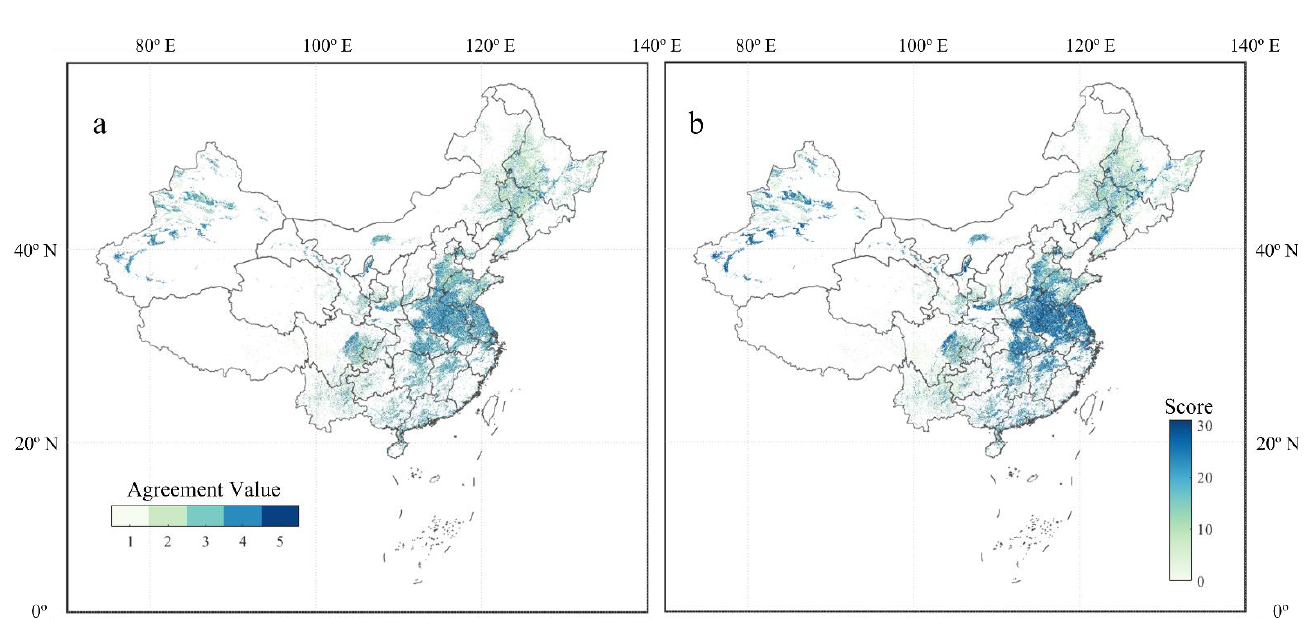
Figure 3. The spatial agreement levels ( a ) and scores ( b ) based on five groups of input data. The benchmark year is 2010.